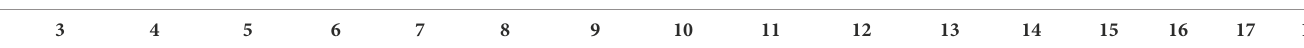
TABLE 1 Descriptive information and correlations between the study